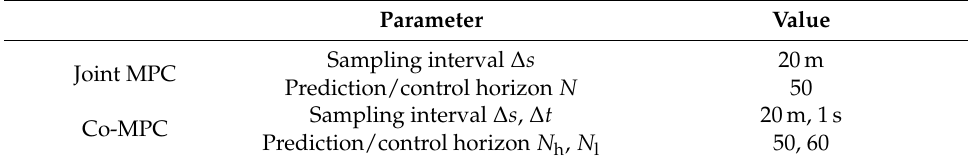
Table 2. Parameters of the joint MPC and